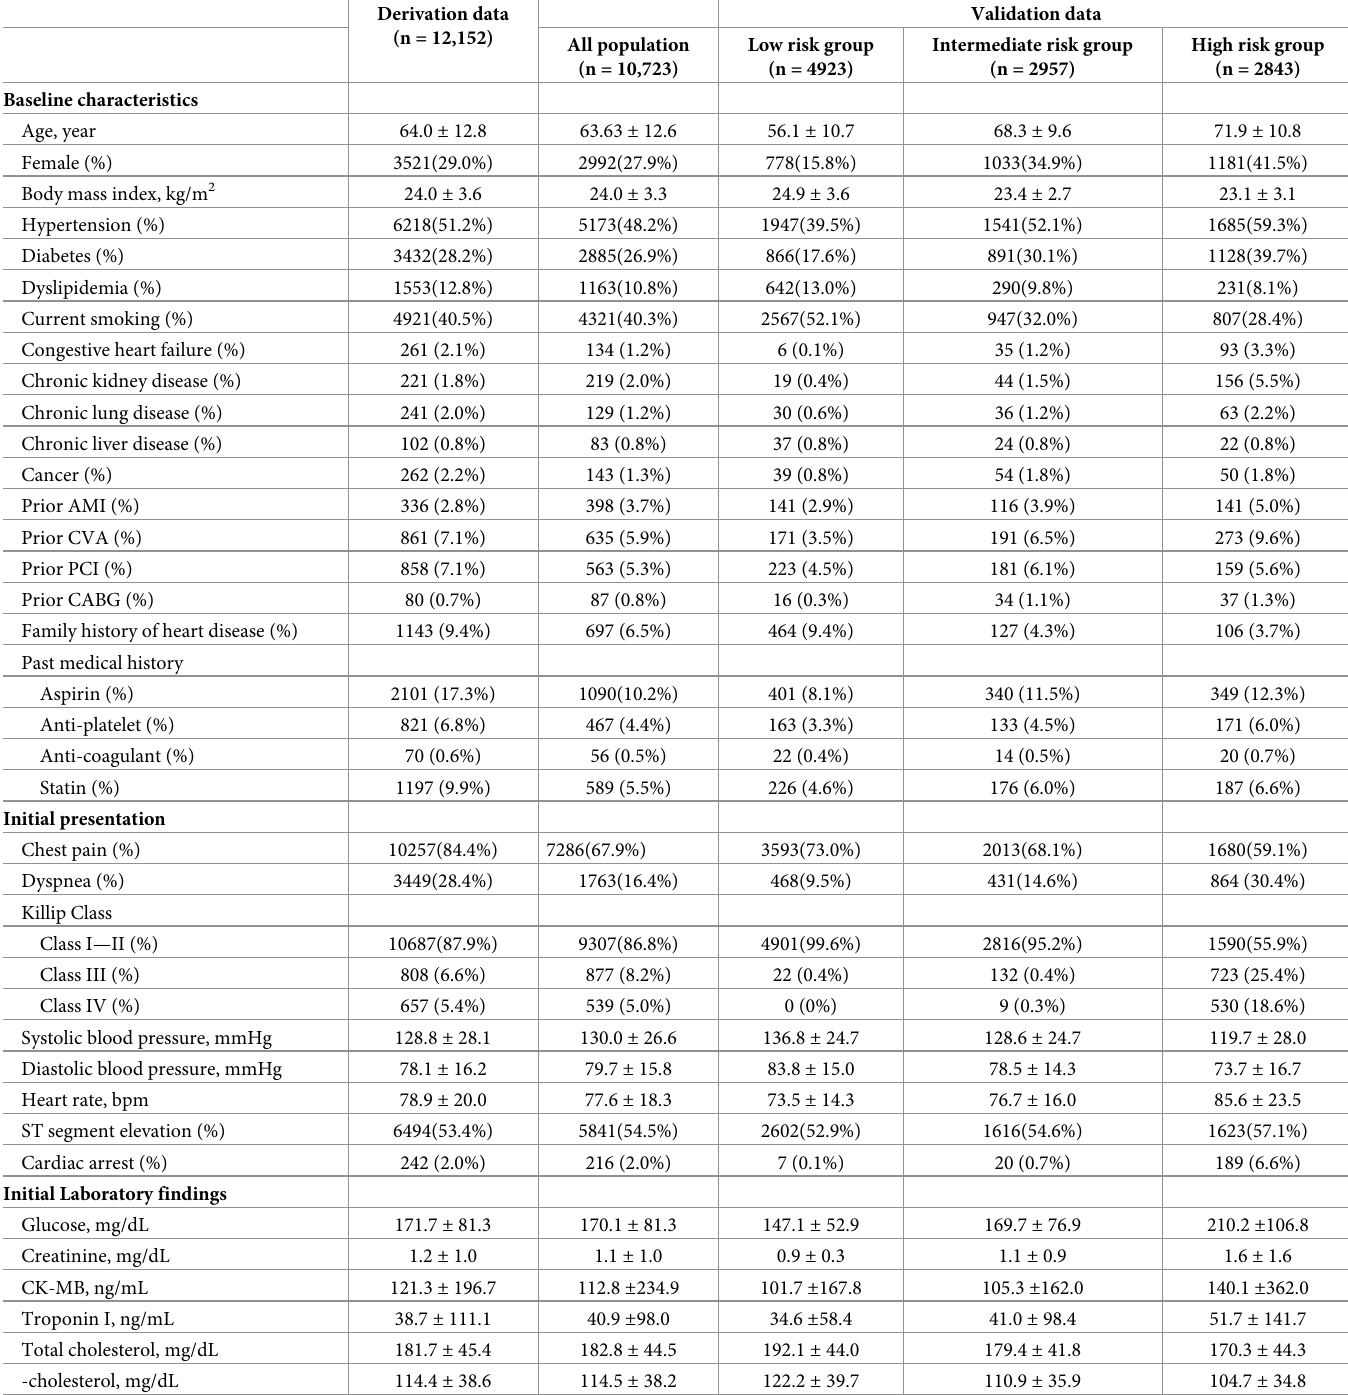
Table 1. Baseline characteristics of study